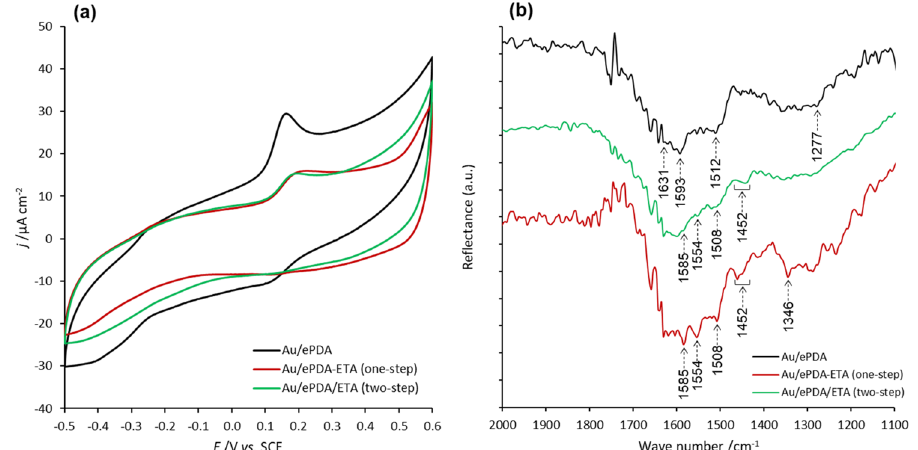
Figure 4. Cyclic voltammograms ( a ) and FTIR spectra ( b ) of gold electrodes modified with polydopamine (Au/ePDA), poly(dopamine-ethanolamine) (Au/ePDA-ETA) and polydopamine film after incubation in ethanolamine solution (Au/ePDA/ETA). Cyclic voltammograms were recorded at 50 mV s −1 in CPB pH